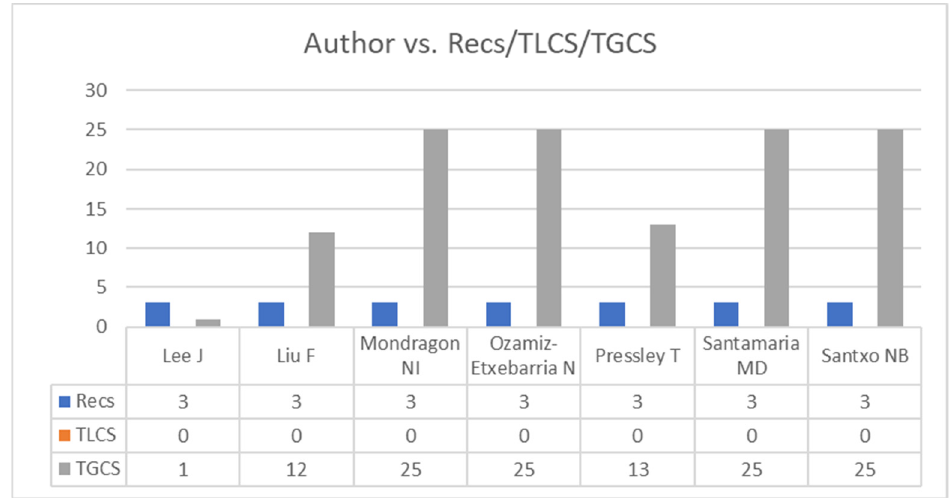
Figure 2. Authors with the most publications ( ≥ 3 Recs). Note: Recs is the number of articles, TLCS is the local citation score and TGCS is the global citation score.